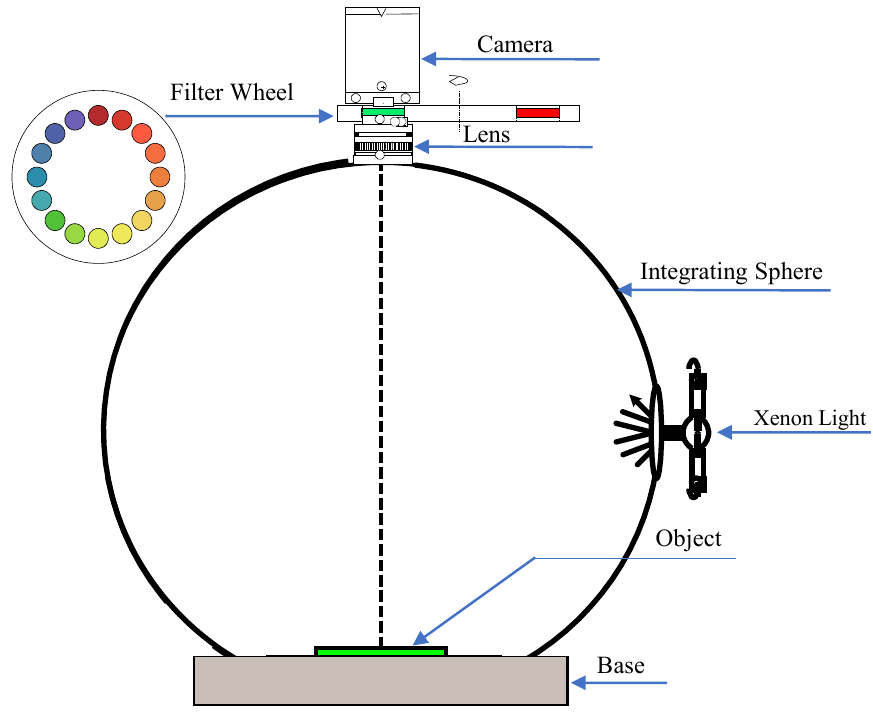
Figure 2. The construction of our